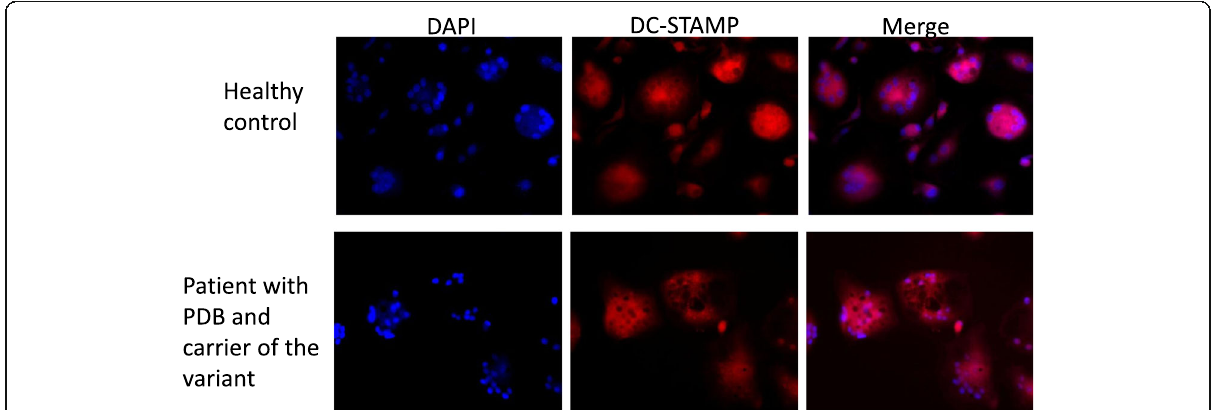
Fig. 2 Immunofluorescence of DC-STAMP in osteoclast cultures at day 21 in cells from a healthy donor and a patient with Paget ’ s disease of bone (PDB) and carrier of the rare